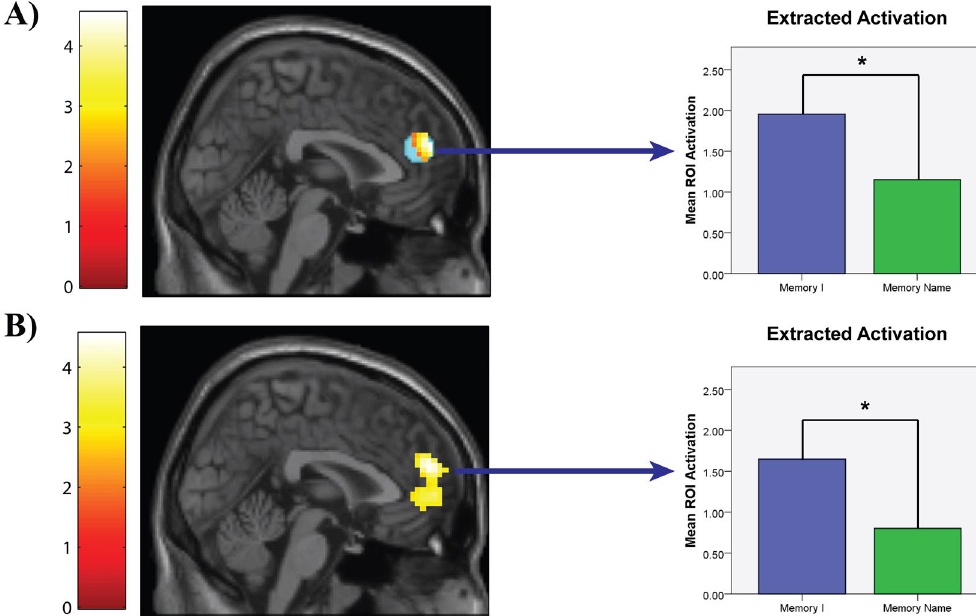
Figure 3. Study 2 (fMRI) Results. Brain imaging results from Study 2 showing that reflecting on negative experiences using “I” instead of one’s own name (I > Name Contrast) is associated with significantly more activity in a region of the medial prefrontal cortex identified as playing a role in self-referential processing in ( A ) a region of interest (ROI colored in blue; activations observed within a priori ROI are overlaid in yellow- orange coloring) and ( B ) whole-brain analysis. Adjacent to each brain map is a bar graph illustrating the extracted mean activation between “I” and “Name” trials from each analysis. * represents p <